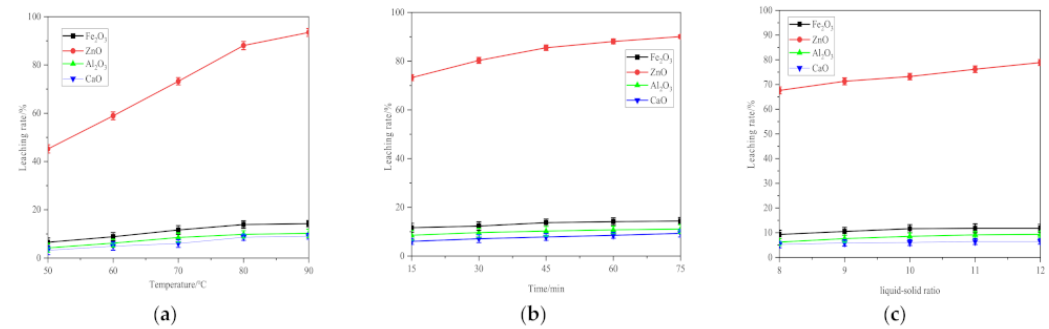
Figure 7. Leaching rates of metal oxides under different leaching conditions. ( a ): Leaching rates at different temperatures. ( b ): Leaching rates at different times. ( c ): Leaching rate of different liquid solid